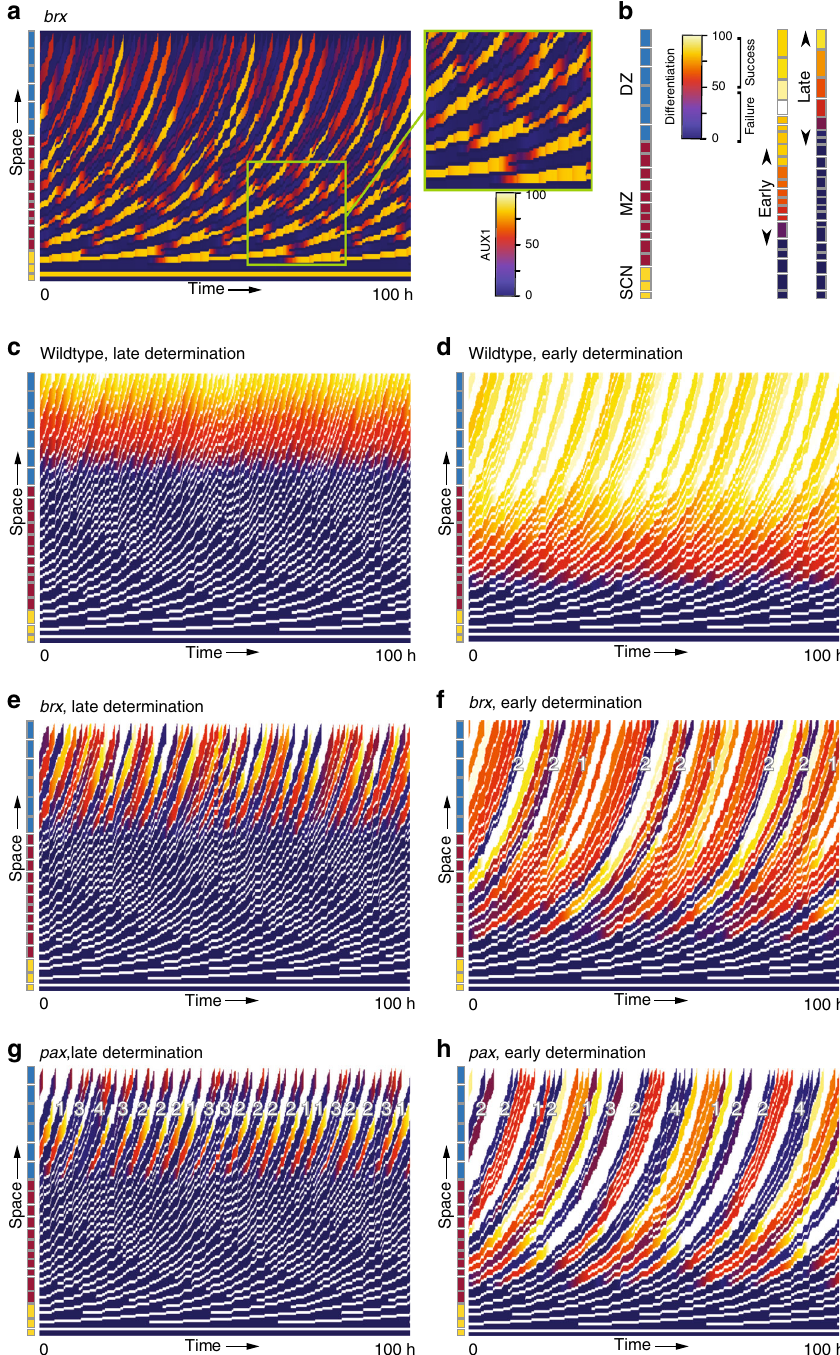
Fig. 5 Early fate determination explains differentiation patterns. a Kymograph of cellular AUX1 expression levels for a brx mutant in the PPSE-strand model. The inset shows details of AUX1 dynamics in the meristematic zone, highlighting the transient presence of single, double-sized cells just prior to division, and slightly later divided cell pairs with differential AUX1 expression. b Snapshots of differentiation dynamics for wild type in the case of early and late fate determination, respectively. Arrows indicate the PPSE zone in which fate is determined for the respective differentiation scenarios. c – g Differentiation kymographs for wild type, brx , and pax mutants in the two scenarios. Numbers in e – h indicate gap sizes. For brx , only 1-cell gaps (not marked) are observed in the late